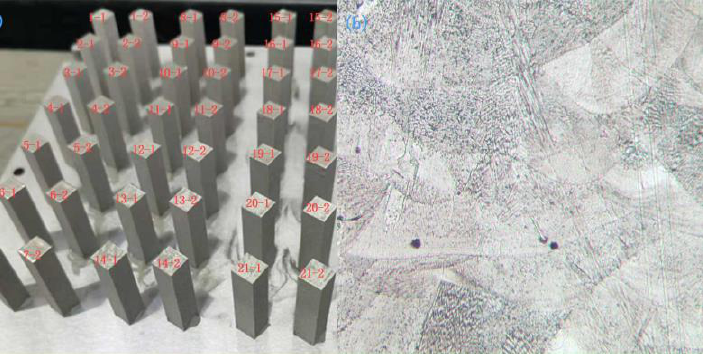
Figure 5. Diagram of experimental sample and microstructure. ( a ) LPBF-build plate with manufac- tured samples and ( b ) microstructure, XZ plane.